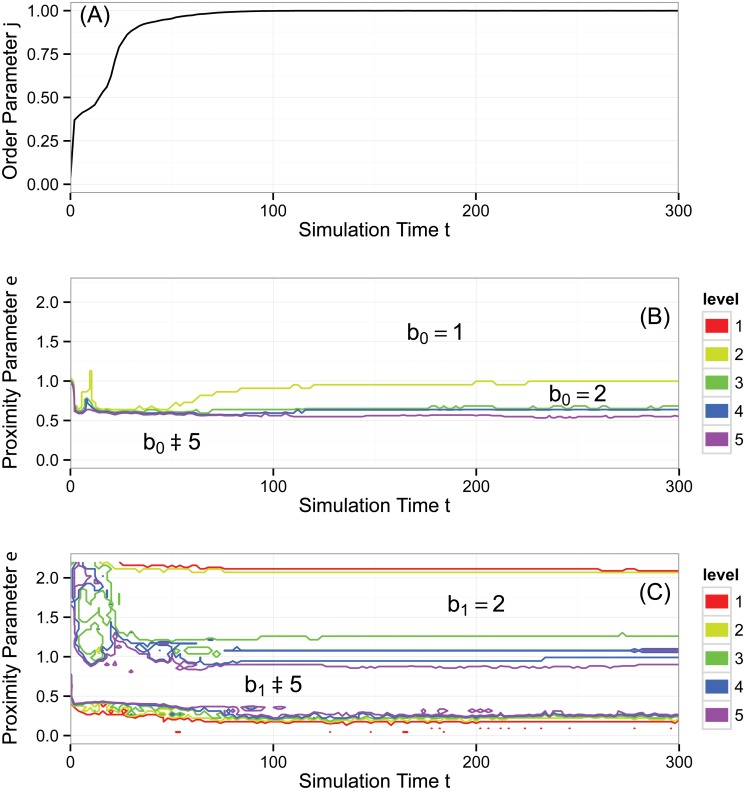
Aggregate behavior of the Vicsek model, simulation #3.A typical snapshot is shown in Fig 7(C). (A) Normalized average velocity order parameter φ(t). (B) Contour plot of Betti number b0(ɛ,t). (C) Contour plot of Betti number b1(ɛ,t). The topological analysis shows essentially no cluster formation; the narrow region in which b0(ɛ,t)=2 arises from an isolated agent. The two persistent topological circles are consistent with highly aligned particles covering both dimensions of the periodic spatial domain. Topological features become fairly stagnant once the entire group forms a large, aligned cluster traveling as a rigid body early in the simulation. See text for a more comprehensive analysis.